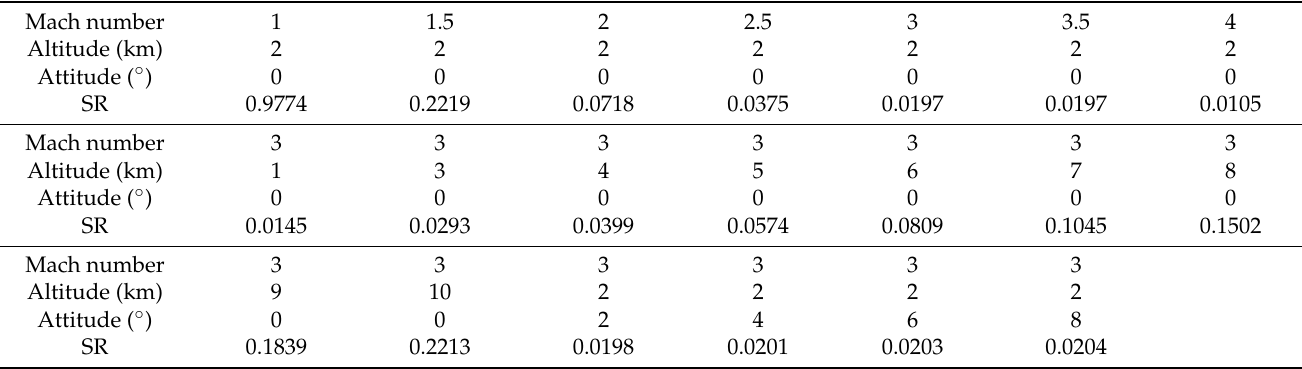
Table 3. SR under different flight